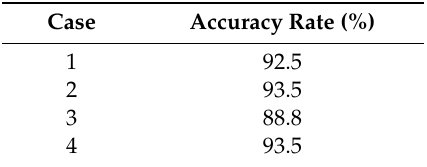
Table A1. CNN verification among cases in binary classification.